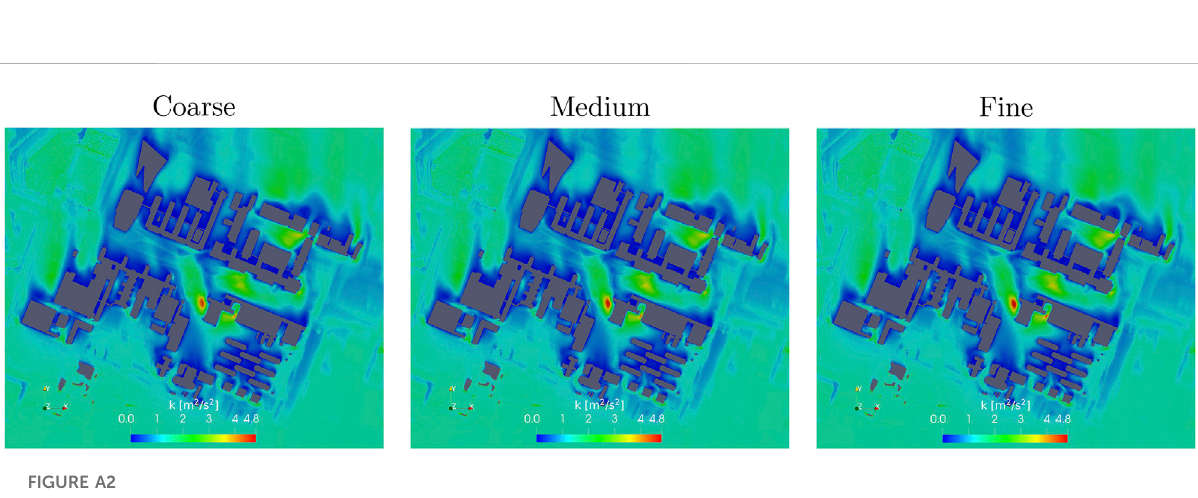
FIGURE A2 TKE fi elds for all three investigated